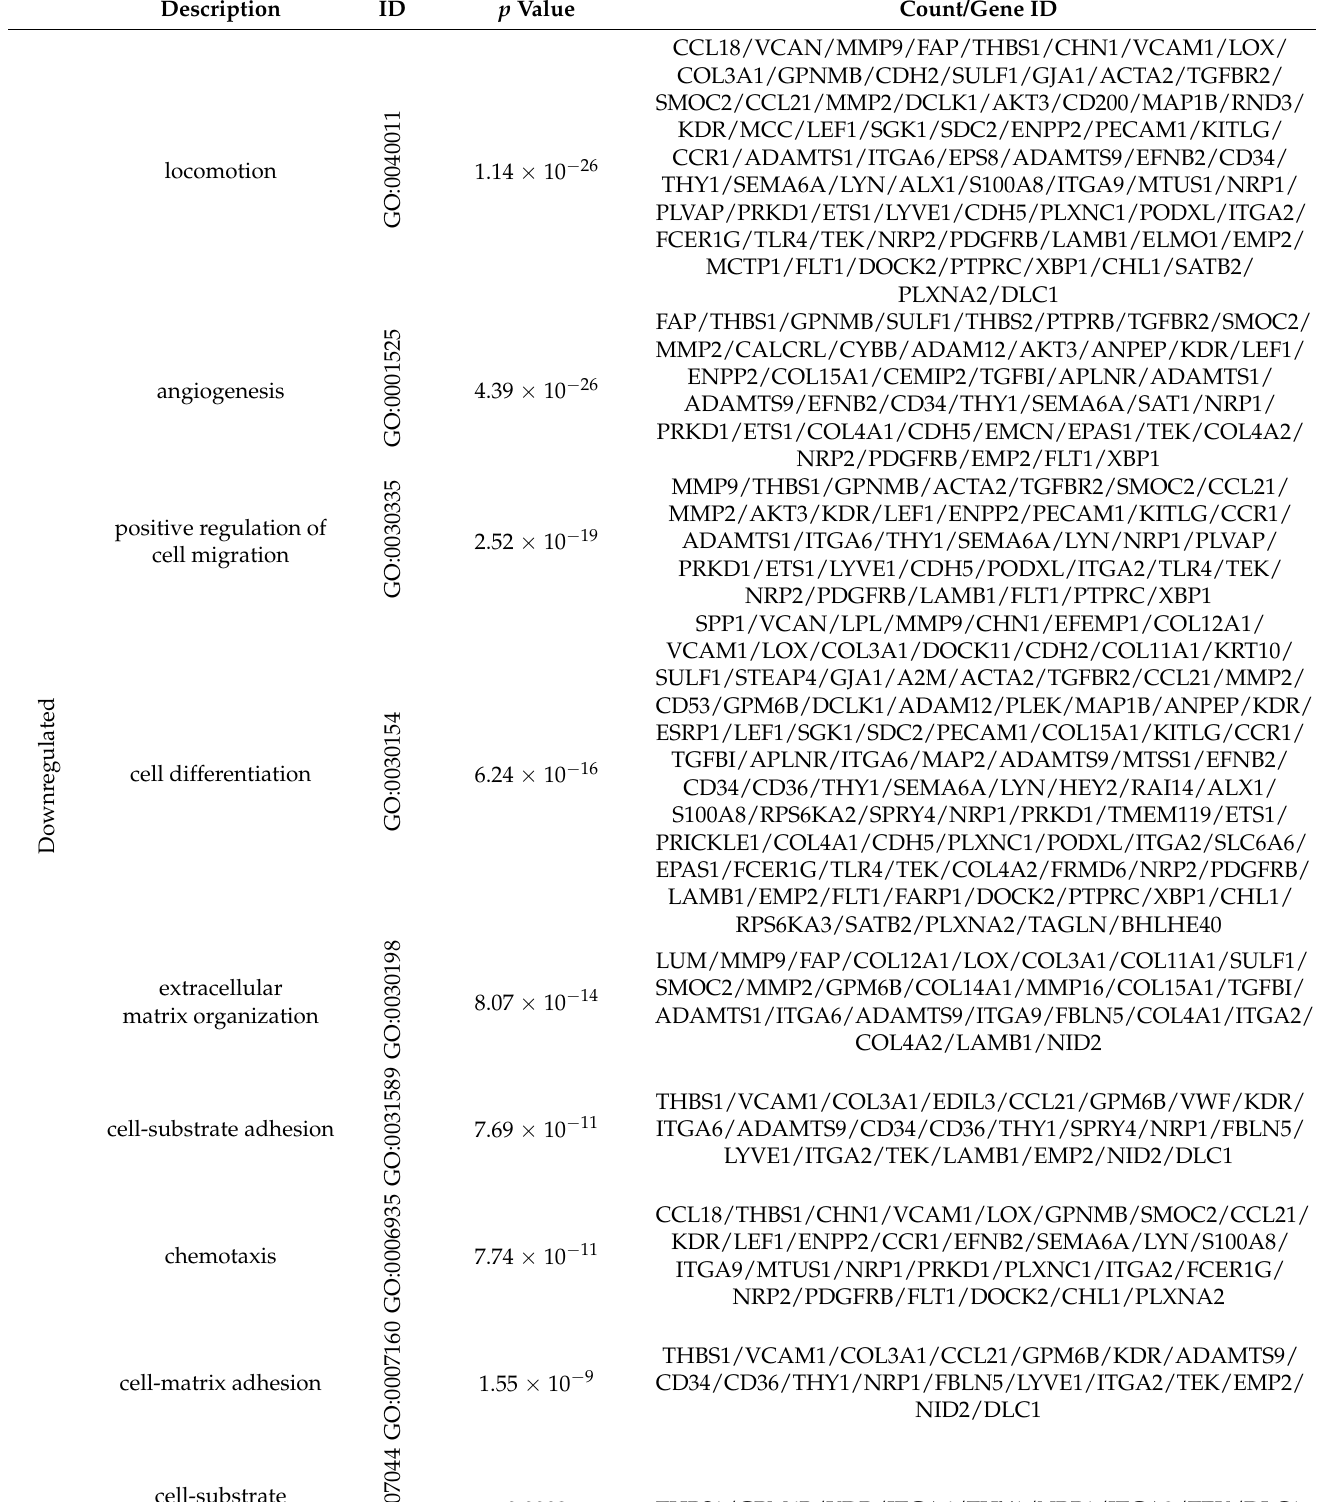
Table 2. The biological process and pathways regulated by